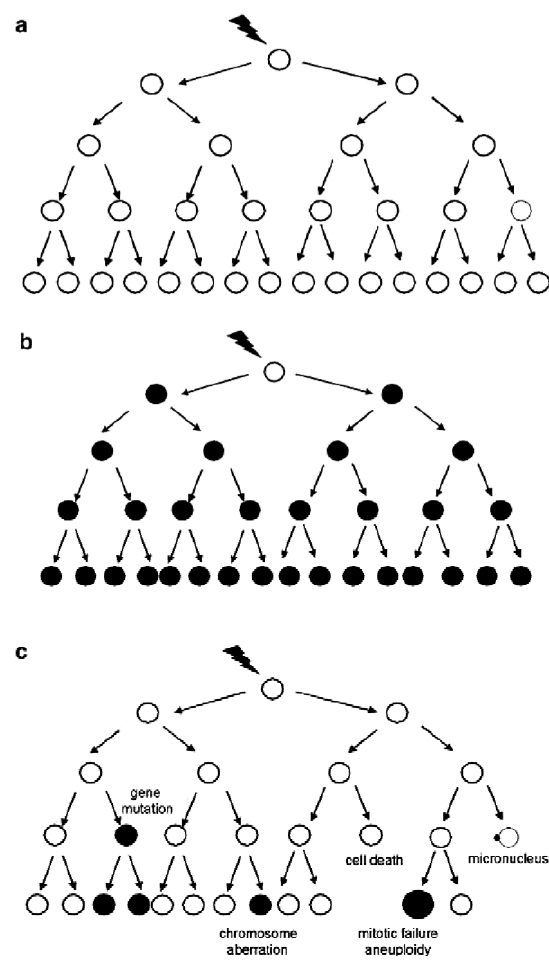
Fig. 1. Models of the responses of clonogenic cells to ionizing radia- tion with mutations and/or chromosomal aberrations shown as filled circles and apparently normal cells as open circles. (a) If a cell faith- fully repairs DNA damage then its clonal descendants will appear normal. (b) If a cell is directly mutated by radiation then all its de- scendants will express the same mutation. (c) Radiation-induced ge- nomic instability is characterized by non-clonal effects in descendant